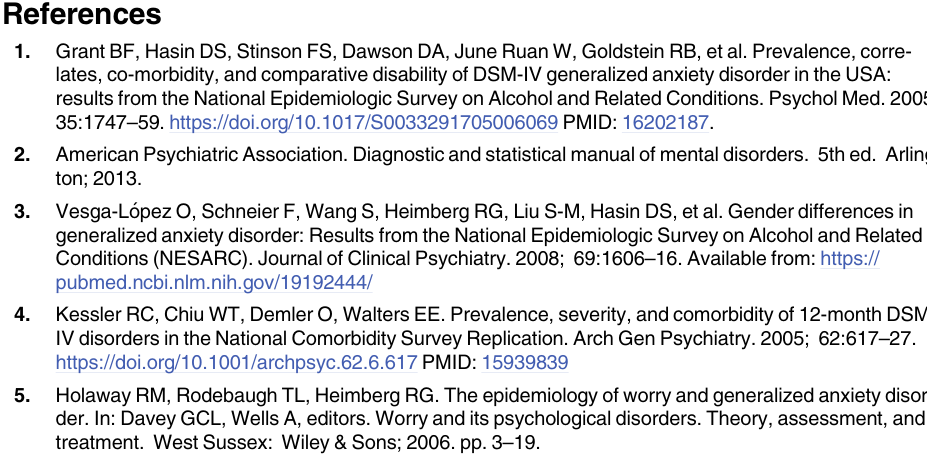
S1 Table. Pooled correlations between all